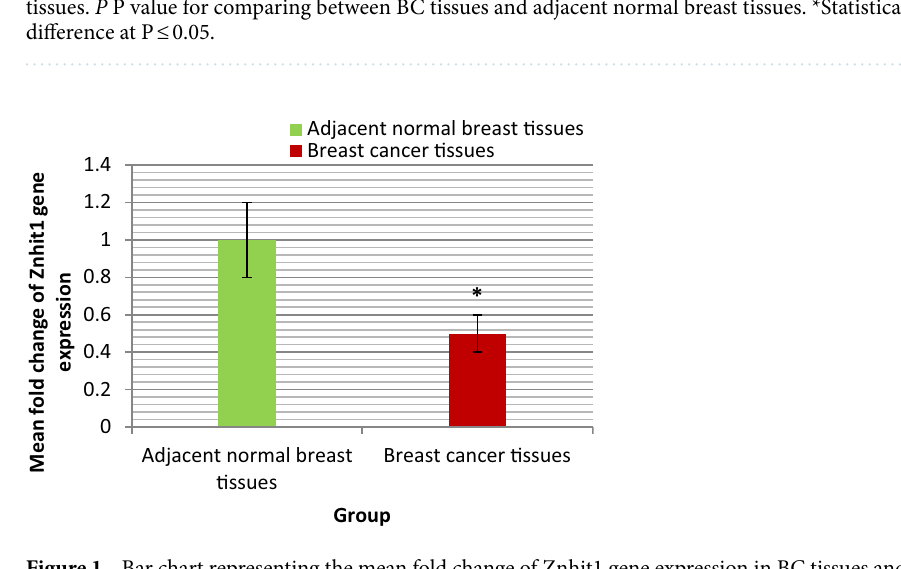
Figure 1. Bar chart representing the mean fold change of Znhit1 gene expression in BC tissues and adjacent normal breast